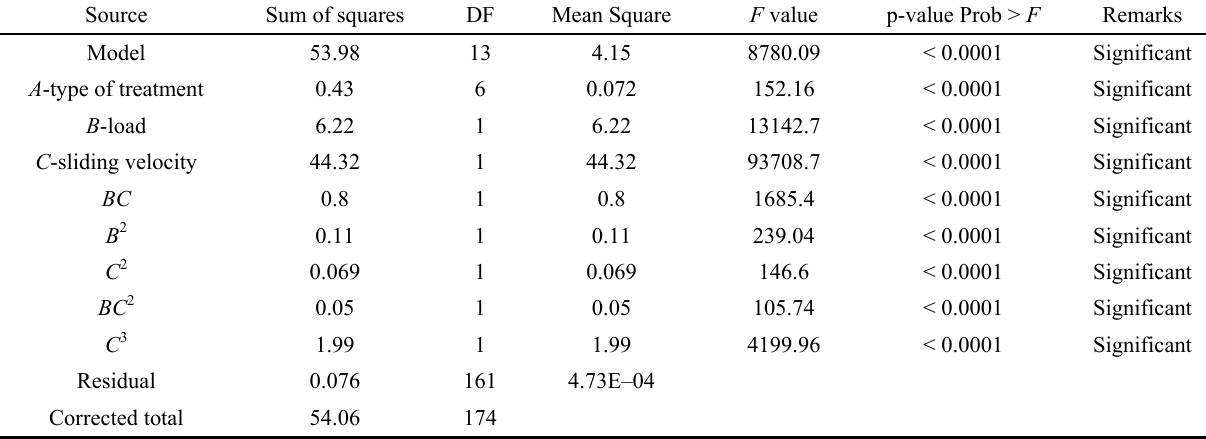
Table 6 Modified ANOVA for the case of W R .